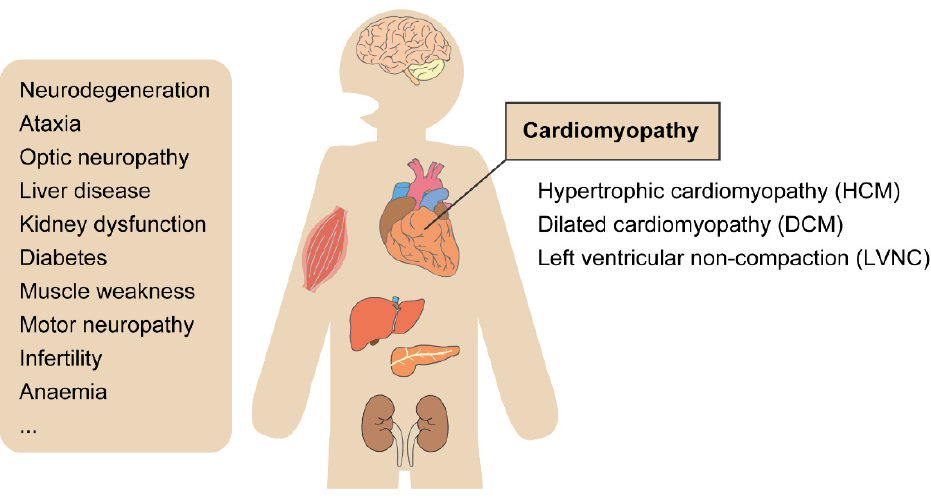
Figure 2. Variations in mitochondrial disease symptoms. Mitochondrial diseases can occur in chil- dren and adults and can affect a wide variety of organs, including multiple organs that have no functional connection to each other, such as the brain and liver, or beta cells of the pancreas and auditory system. Typically, these diseases are progressive. MCM could be described as a myocardial disorder characterized by abnormal cardiac-muscle structure, function, or both, secondary to ge- netic defects involving the mitochondrial respiratory chain. The presentations of MCMs include HCM, DCM, and LVNC, and the severity can range from no symptoms to devastating multisys- temic diseases.